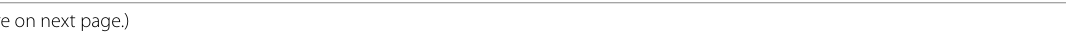
Fig. 6 Influence of Staphylococcus_xylosus and Staphylococcus_lentus on the improvement of resveratrol on liver fibrosis. The pure cultures of the Staphylococcus_lentus and Staphylococcus_xylosus (10 9 CFU) were given to mice by gavage, and then the liver fibrosis model of mice was induced by the intraperitoneal injection of CCl 4 (0.5 µL/g), and the mice were treated with resveratrol (30 mg/kg) daily by gavage. A The protocol for in vivo assays, and representative images of Sirius red staining (scale bar 50 µm) and Immunohistochemical staining (scale bar 50 µm) of α-SMA on = = mouse liver tissues. N 6. B Quantitative results for the Sirius red staining. Brown-Forsythe and Welch ANOVA with Games-Howell’s post-hoc, = Mean SD, N 6. C Quantitative results for the Immunohistochemical staining of α-SMA. Brown-Forsythe and Welch ANOVA with Games-Howell’s ± = post-hoc, Mean SD, N 6. D The concentrations of ALT, AST and ALP in the mouse blood samples were measured using different detection kits, ± = ALT, AST: Brown-Forsythe and Welch ANOVA with Games-Howell’s post-hoc; ALP: one-way ANOVA with Tukey’s post-hoc, Mean SD, N 10. E ± = Comparison of the Hyp level by a commercial kit, one-way ANOVA with Tukey’s post-hoc, Mean SD, N 10. F Analysis of the concentration of LBP ± = in the mouse blood samples using a commercial kit, Brown-Forsythe and Welch ANOVA with Games-Howell’s post-hoc, Mean SD, N 10. G The ± = mRNA levels of ZO-1 and occludin were assessed by qRT-PCR. N 10. H The relative ZO-1 positive areas were measured using immunofluorescence = (scale bar 50 µm). N 6. ** P < 0.01, *** P < 0.001, **** P < 0.0001 vs. Control. # P < 0.05, ## P < 0.01, ### P < 0.001 vs. CCl 4 . a P < 0.05, aa P < 0.01, aaa P < 0.001, = = aaaa P < 0.0001 vs.